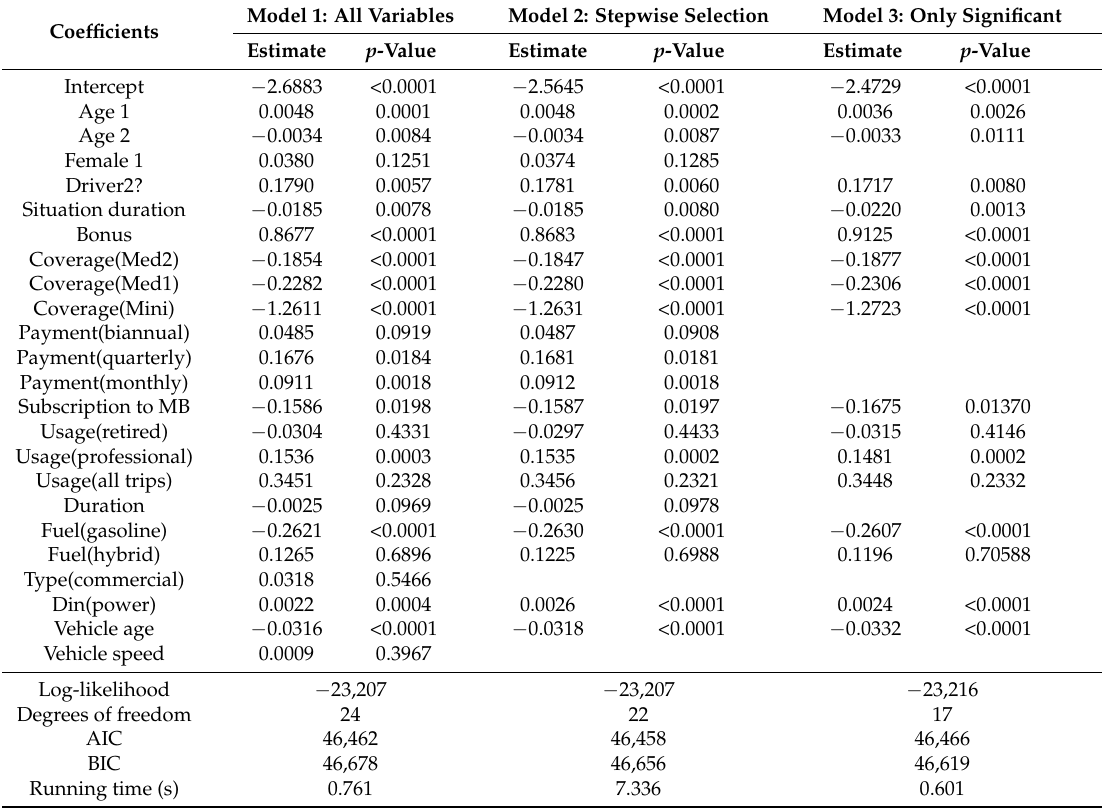
Table 4. Regression coefficient of Poisson